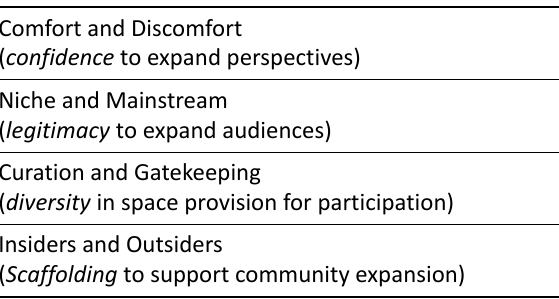
Table 3. Model of participation